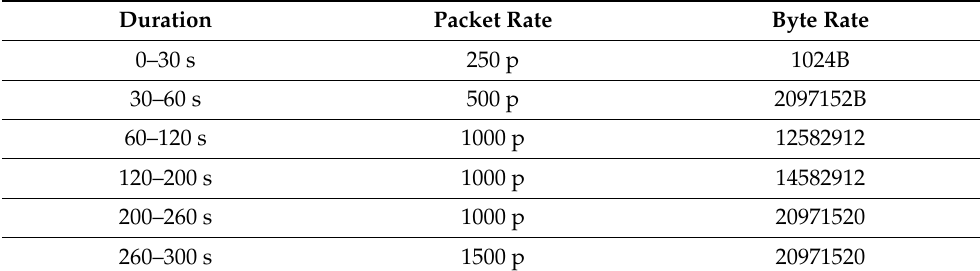
Table 1. UDP Packets Generated During 300 s of Simulation.